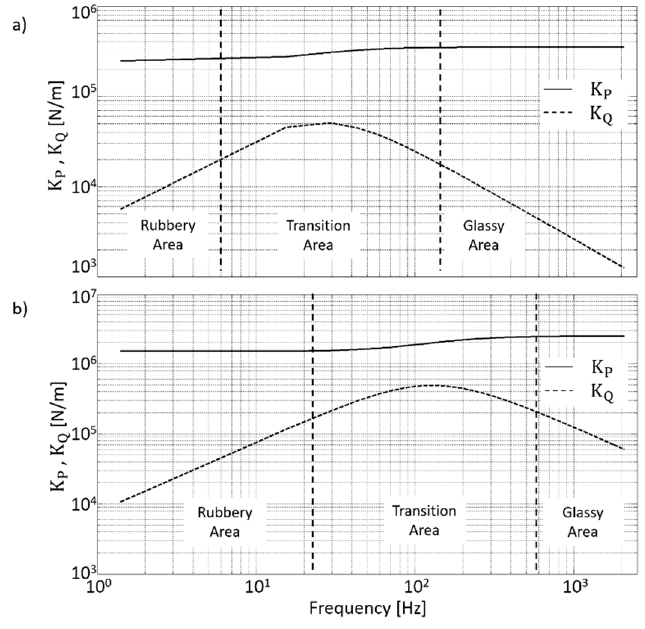
Figure 8. Dynamic behavior of the damper usable in rotordynamic models. In-phase stiffness K P (solid line). In-quadrature stiffness K Q (dash-dotted line). ( a ) SES support of the turbo-molecular pump. ( b ) CS support of the turbo-molecular pump.